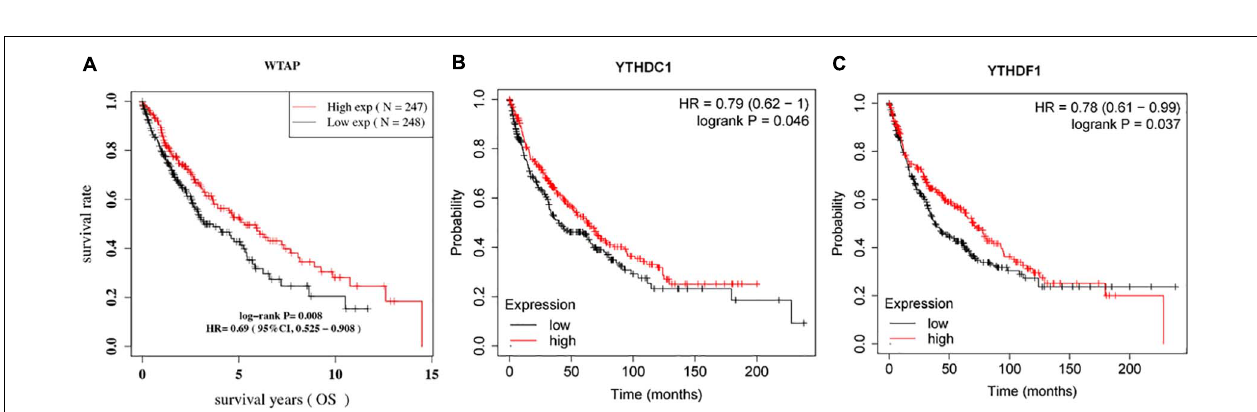
Frontiers in Cell and Developmental Biology |